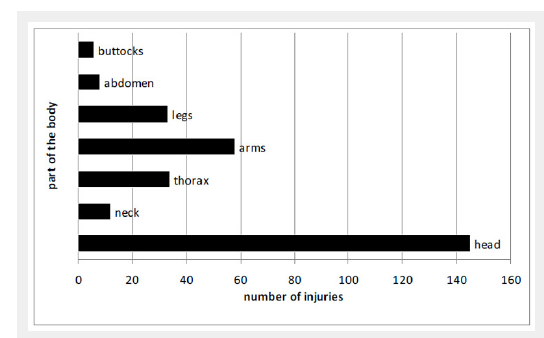
Identified cases of domestic violence per year from 2000 to